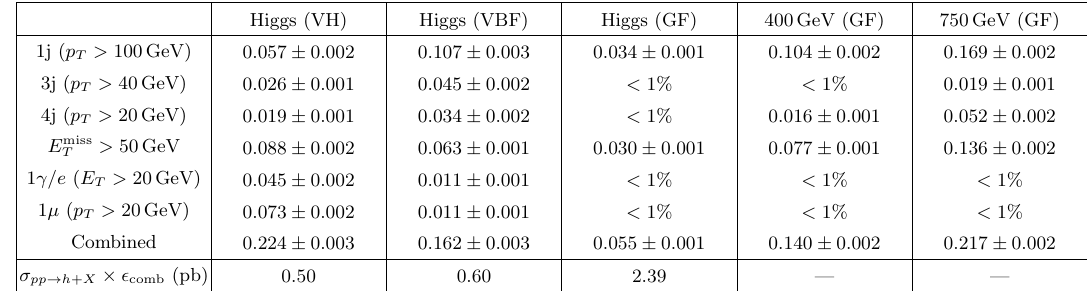
Table 2. L1 e(cid:14)ciencies for the di(cid:11)erent benchmarks and trigger paths, where the quoted uncer- tainties are statistical only. For the Higgs portal benchmark, the last row indicates production Higgs cross section [95] multiplied with combined L1 trigger e(cid:14)ciency ( (cid:15) comb ). correlated over all the events. Turn-on e(cid:11)ects are included for the single jet, multijet, E miss lepton and EM triggers. For the combined trigger e(cid:14)ciency, we neglect possible correlations between the di(cid:11)erent underlying turn-on curves. For the Higgs portal benchmarks we also show the production cross section times the trigger e(cid:14)ciencies. Although the e(cid:14)ciency for the GF mode is comparatively low, it is still the most sensitive channel due to the higher inclusive cross section. The VH and VBF channels nevertheless produce non-negligible contributions to the accepted L1